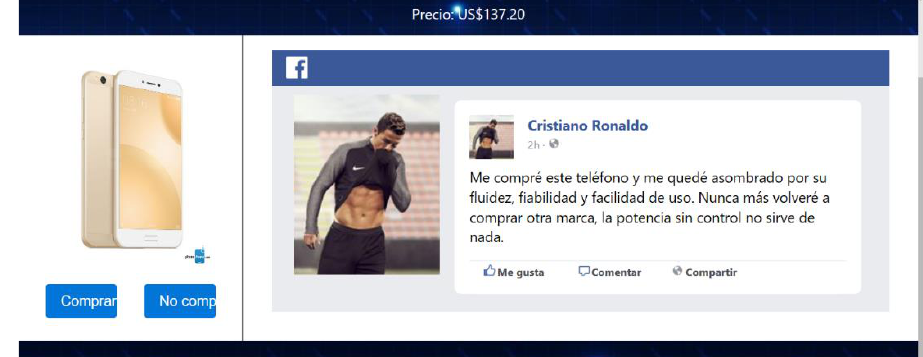
Figure A2. Consumer reviews example.